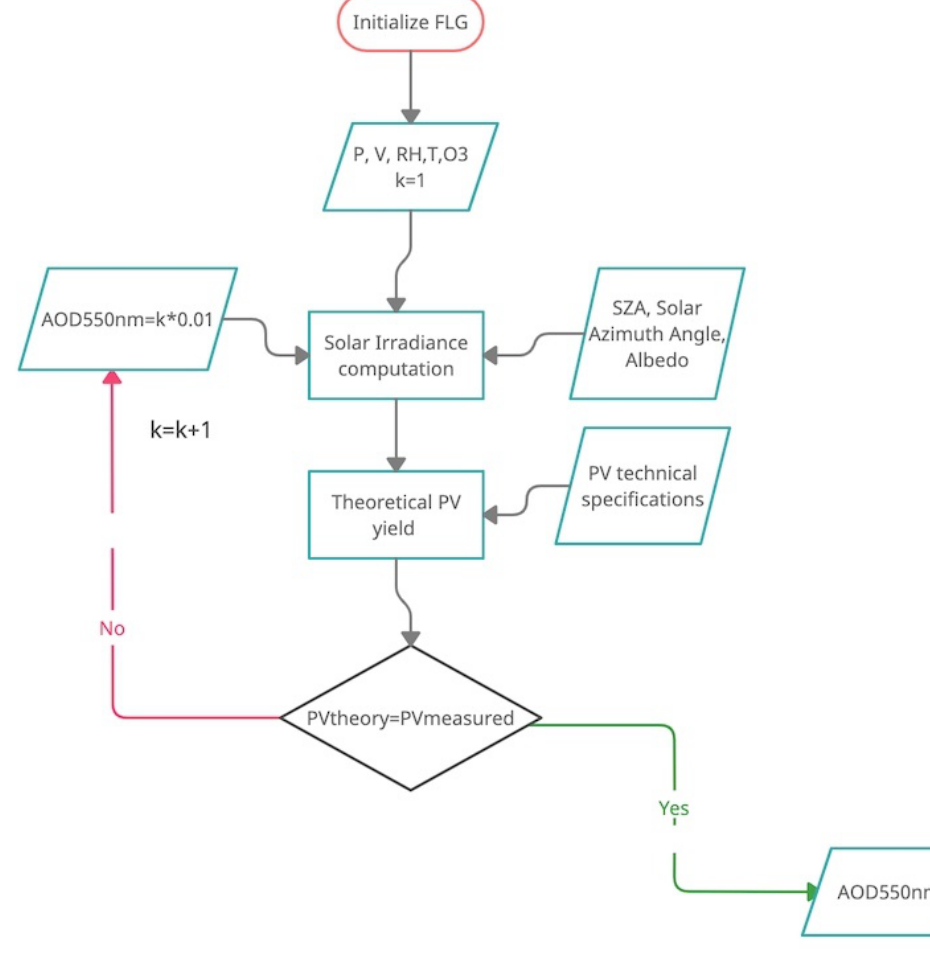
Figure 1. Flowchart representing the iterative process to compute the AOD retrieval at 550 nm. The FLG model uses pre-defined functions to calculate the AOD values at the different wavelengths needed for solar irradiance calculation at